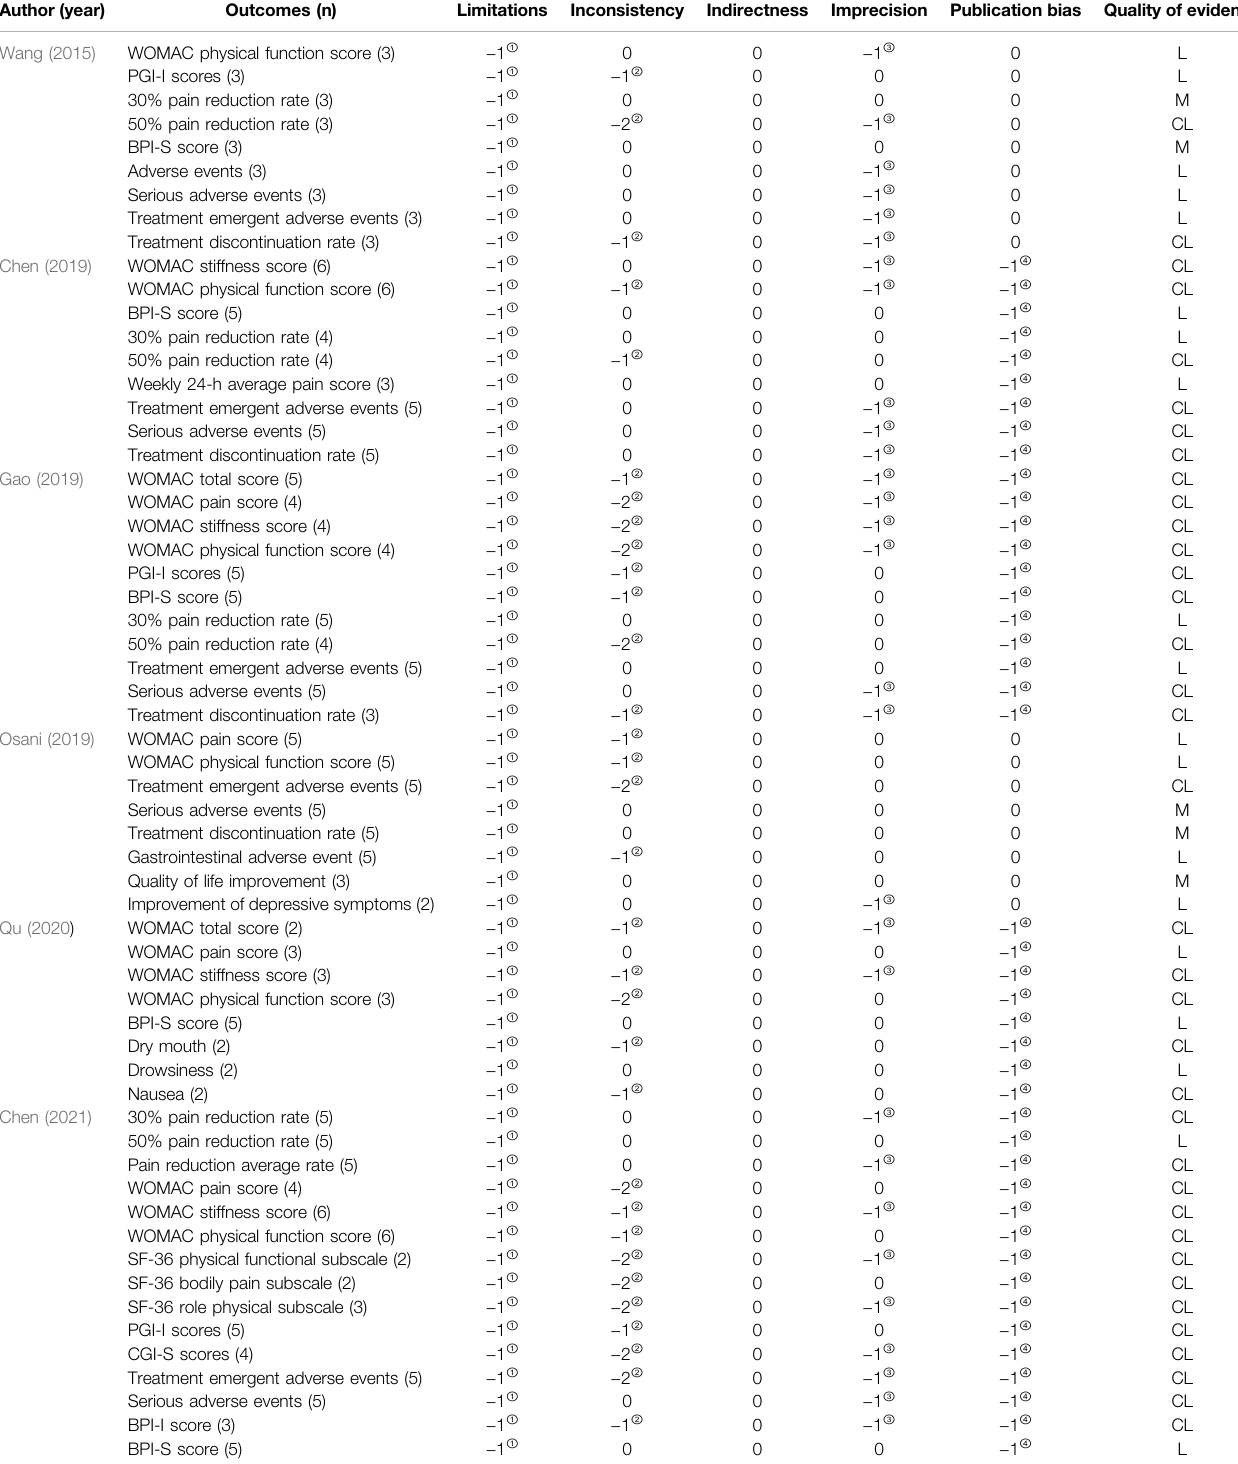
TABLE 6 | GRADE quality grading of included